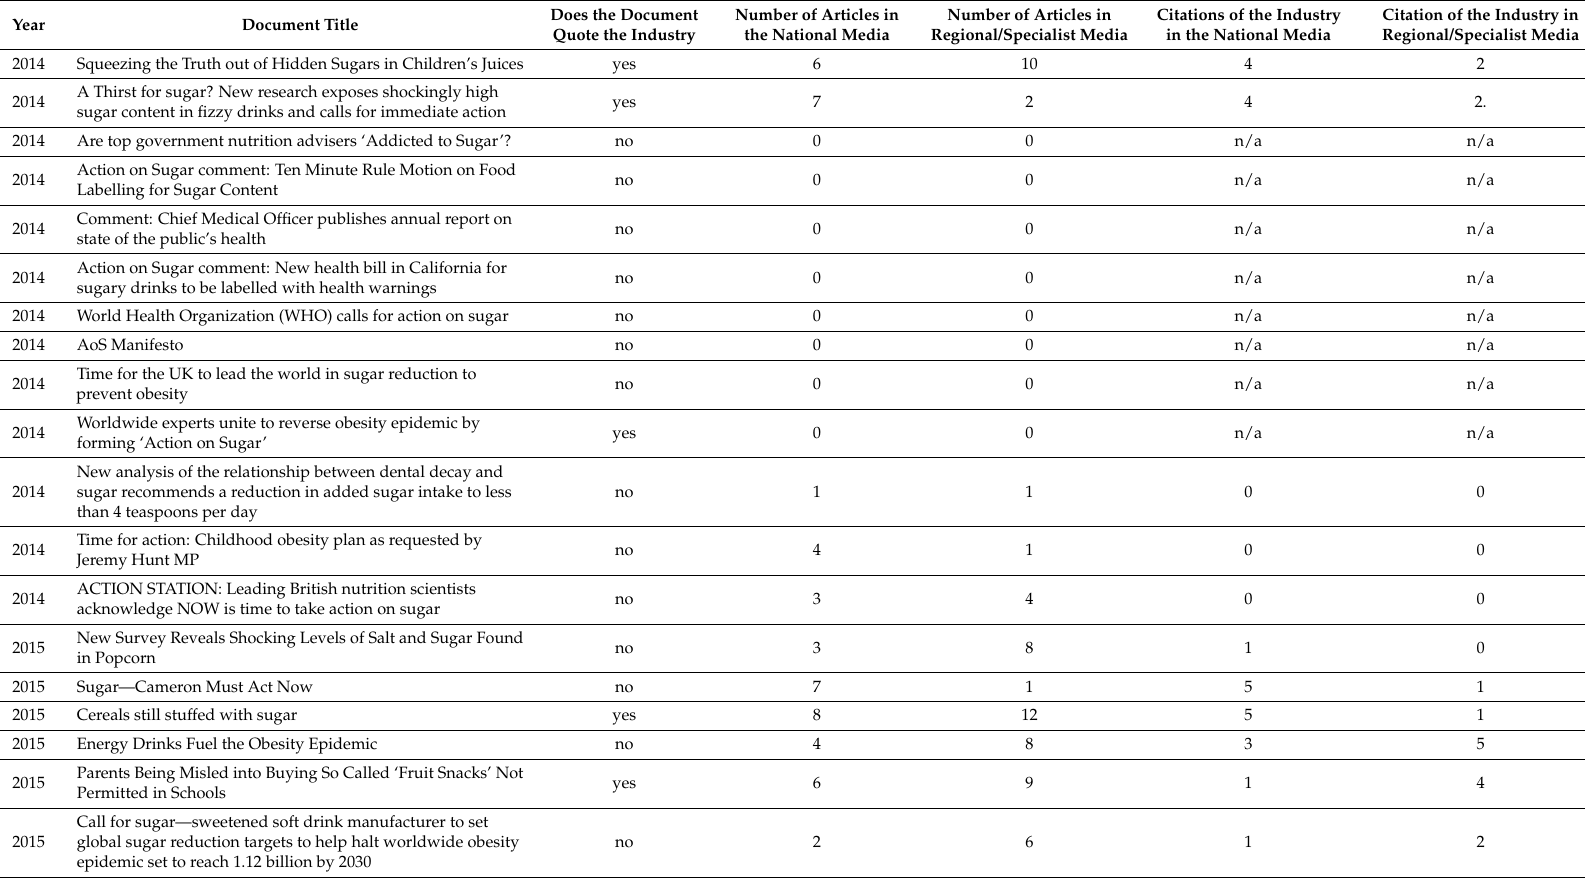
Table 5. Citations of the Industry in Articles following Document Publications from Action on